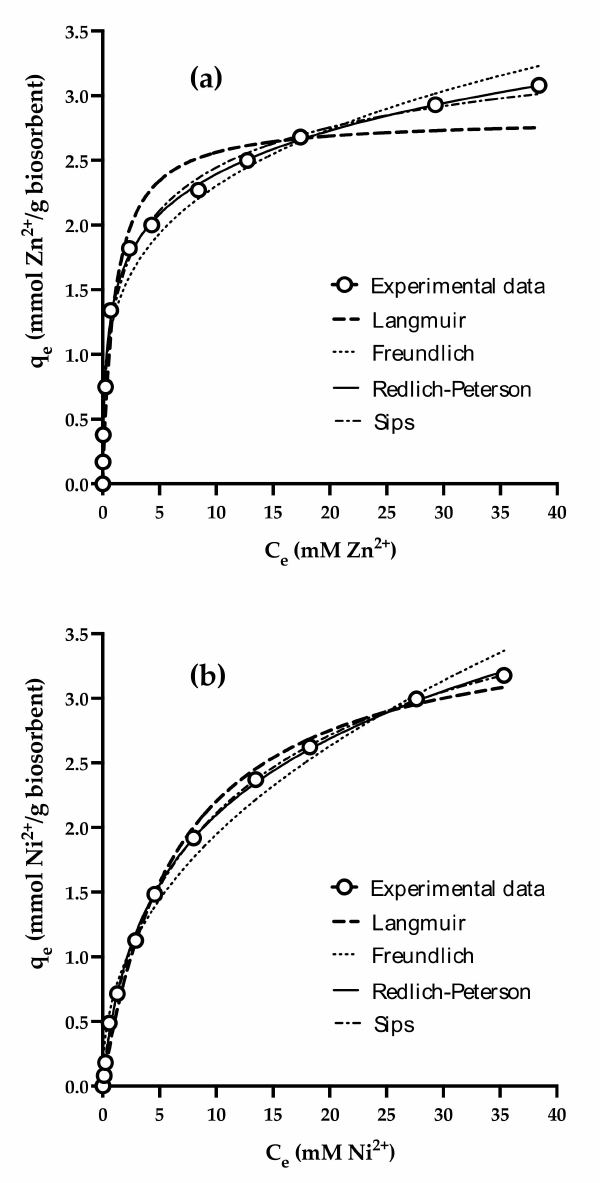
Figure 2. Single-component isotherms of ( a ) Zn 2+ and ( b ) Ni 2+ on CS and comparison of the different isotherm models in terms of describing the heavy metal biosorption process. Conditions: Biosorbent concentration = 1 g/L; temperature = 25 ◦ C; solution pH =